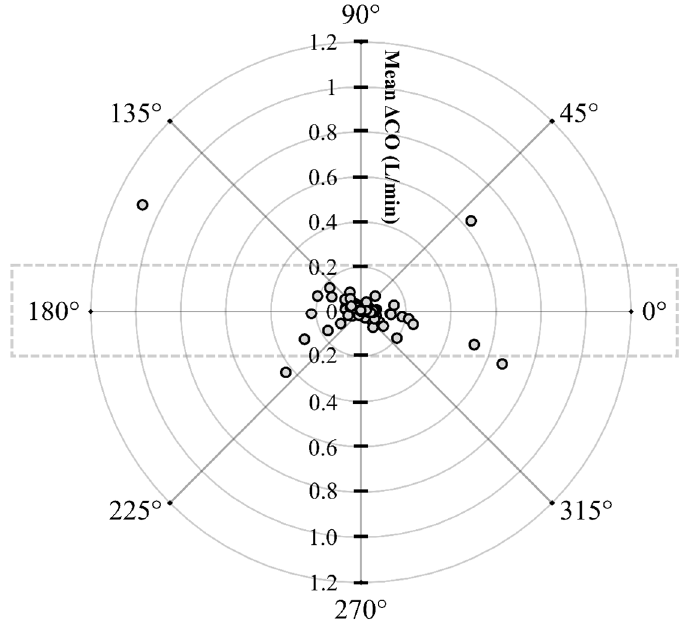
Figure 6. Polar plot displaying changes in cardiac output (CO) measured using electrical cardiometry and pulmonary artery thermodilution methods in anesthetized Beagle dogs ( n = 6) across five timepoints during four hemodynamic events (baseline, hemorrhage, autologous blood transfusion, and colloid infusion), thus yielding 120 paired observations (circles). Dotted lines indicate 10% boundaries (i.e., 10% = 0.206 L/min as mean CO = 2.06 L/min). The distance from the center reflects the absolute values of the mean change in CO ( [ ∆ CO PATD + ∆ CO EC ] /2), and the angle with the horizontal (0 ◦ radial axis) is indicative of a lack of agreement. The polar plot analysis exhibits good trending ability as only four points are located on the exterior of the limits of good agreement.